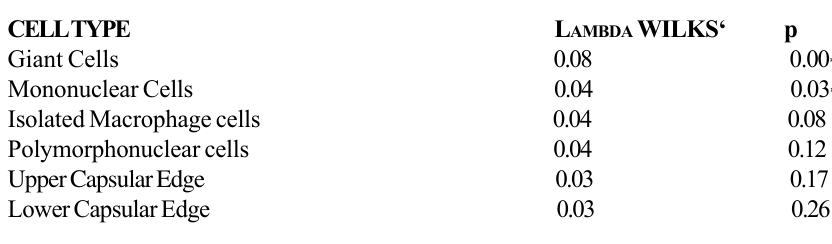
TABLE 8 — Evaluation according to the discriminating analysis